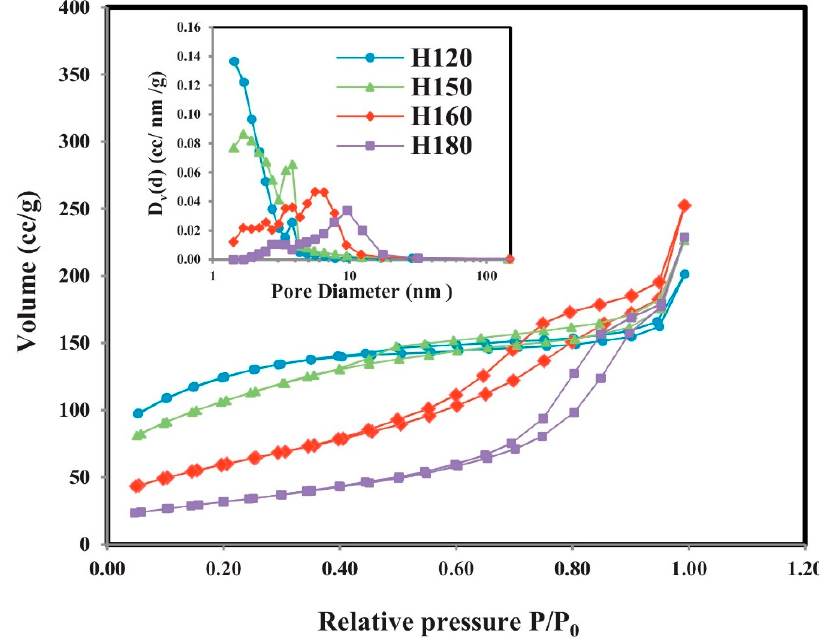
Figure 17. Nitrogen adsorption-desorption isotherms and pore size distribution (inset) of TiO 2